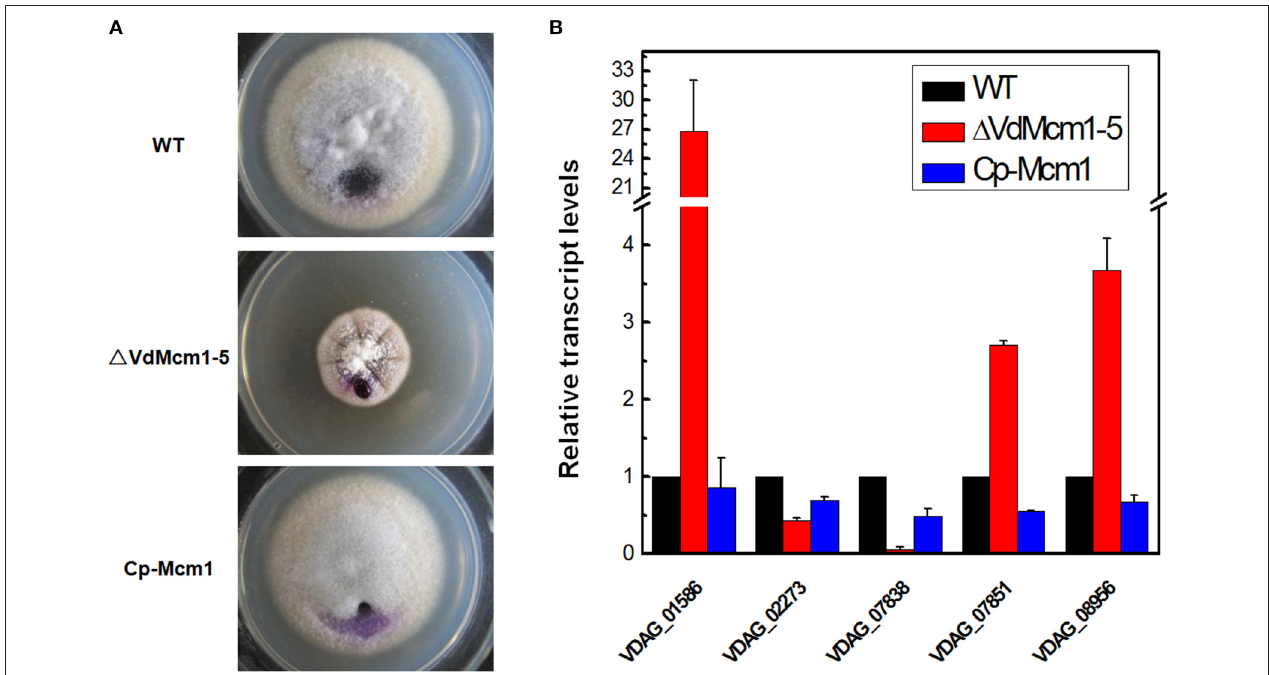
FIGURE 6 | Surface hydrophobicity assay and gene expression analysis. (A) Surface hydrophobicity was tested by spotting 20 µ l water droplets containing 0.12% bromophenol blue on the surface of 16-day-old colonies grown on PDA plates. The pictures were taken after 1 h of incubation at room temperature. (B) Relative gene expression levels of five hydrophobin genes by quantitative real-time PCR. Total RNA of the wild-type strain, 1 VdMcm1-5 , and complemented strain was extracted from the 16-day-old cultures grown on PDA. The β -tubulin gene was used as an internal reference. The error bars represent standard deviations. The experiments were performed in